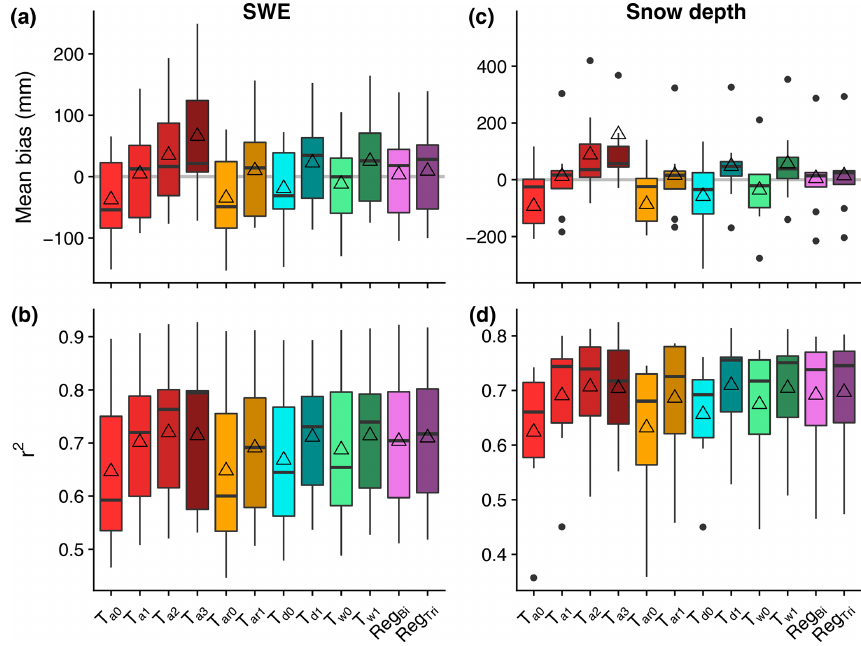
Figure 3. Mean bias (a, c) and r 2 (b, d) values for the SNOWPACK simulations relative to observed SWE (a, b) and snow depth (c, d) . The boxplots show the median, interquartile range, minimum, maximum, and outlying values for each objective function for the different precipitation phase methods at all stations. The open triangles indicate the mean objective function value for that precipitation phase method at all stations.